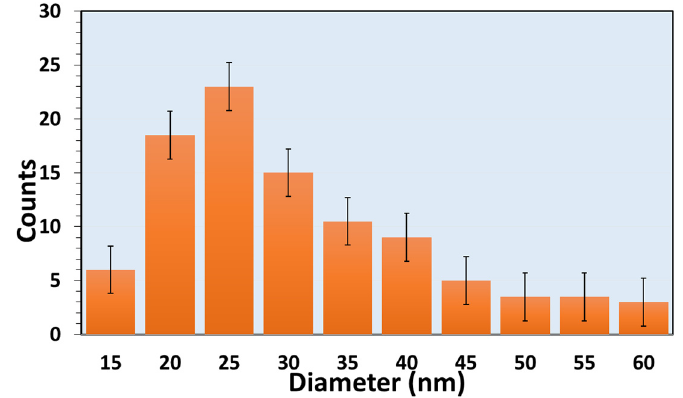
Figure 3. Diameter distribution of the thermally oxidized TiO 2 nanowires growth at 700 °C with 10 SCCM oxygen and 100 SCCM argon flow for 3 h.